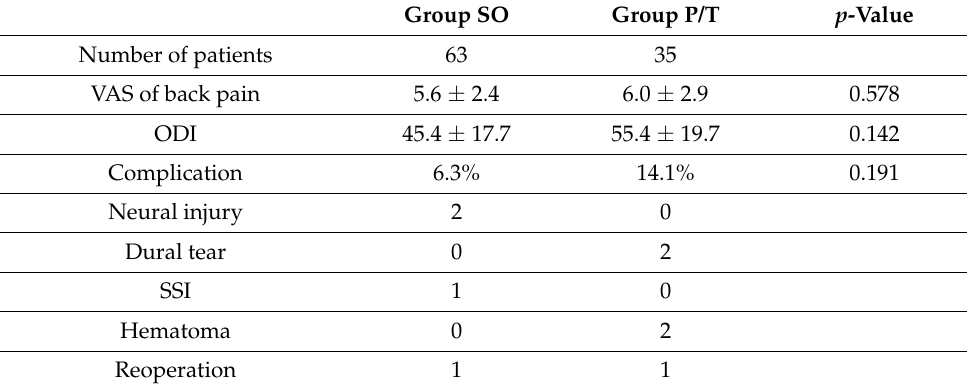
Table 3. Clinical results for Group SO and Group P/T.